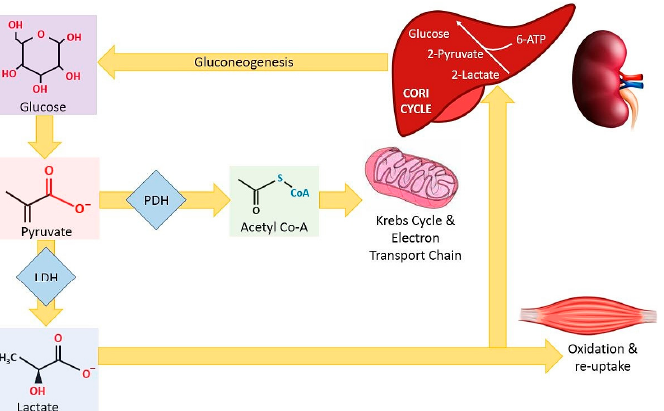
Figure 1. Lactate production and clearance. Under aerobic conditions, pyruvate is converted to acetyl coenzyme A (CoA) via the action of pyruvate dehydrogenase (PDH) in the cytoplasm, which enters the Krebs cycle and electron transport chain in the mitochondria. However, under anaerobic conditions, pyruvate is converted to lactate via the action of lactate dehydrogenase (LDH). Plasma lactate is cleared via action of the liver (and to a lesser degree the kidneys) though the process of gluconeogenesis. Excess lactate is oxidised and is taken up in the